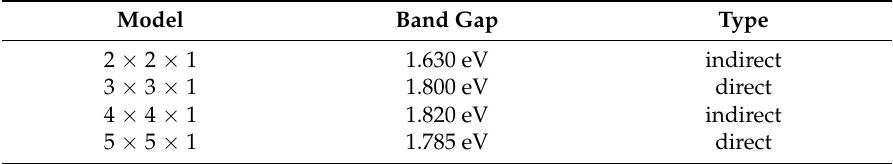
Figure 4. Band structure of different sizes of monolayer WS 2 supercell with one substitutional O atom: ( a ) 3 × 3 × 1; ( b ) 4 × 4 × 1; and ( c ) 5 × 5 × 1. The band gaps are shown with red arrows. Table 2. The band gap and its type of O-doped pure WS 2 monolayer with different supercells. Model Band Gap Type